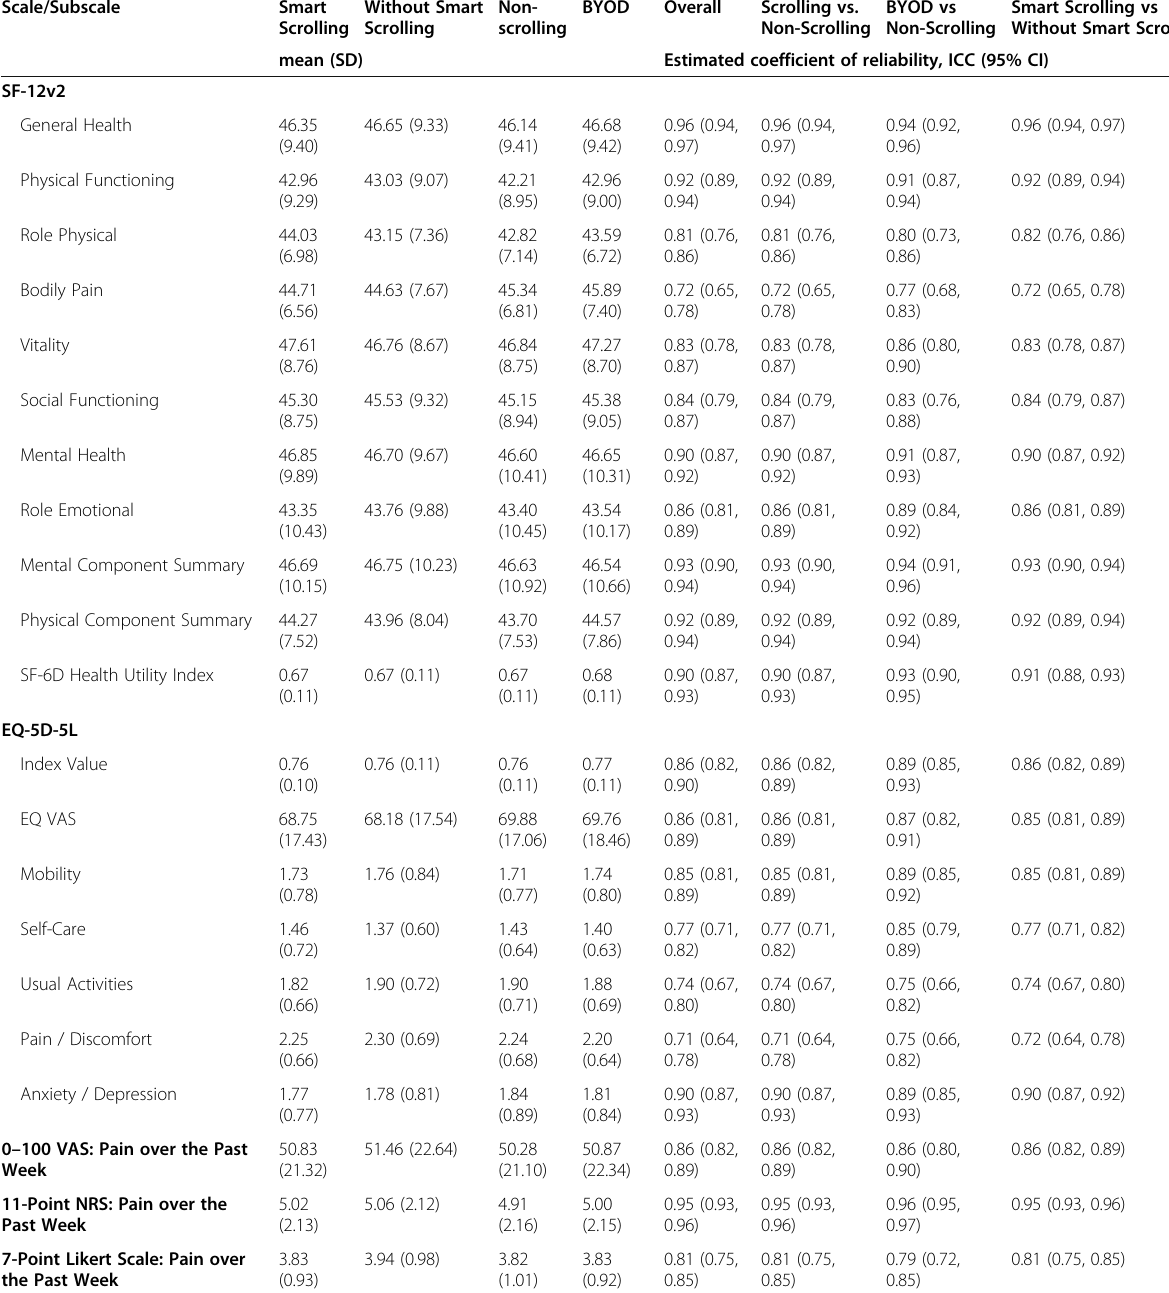
Table 3 Intra-class Correlations for questionnaire items between scrolling features